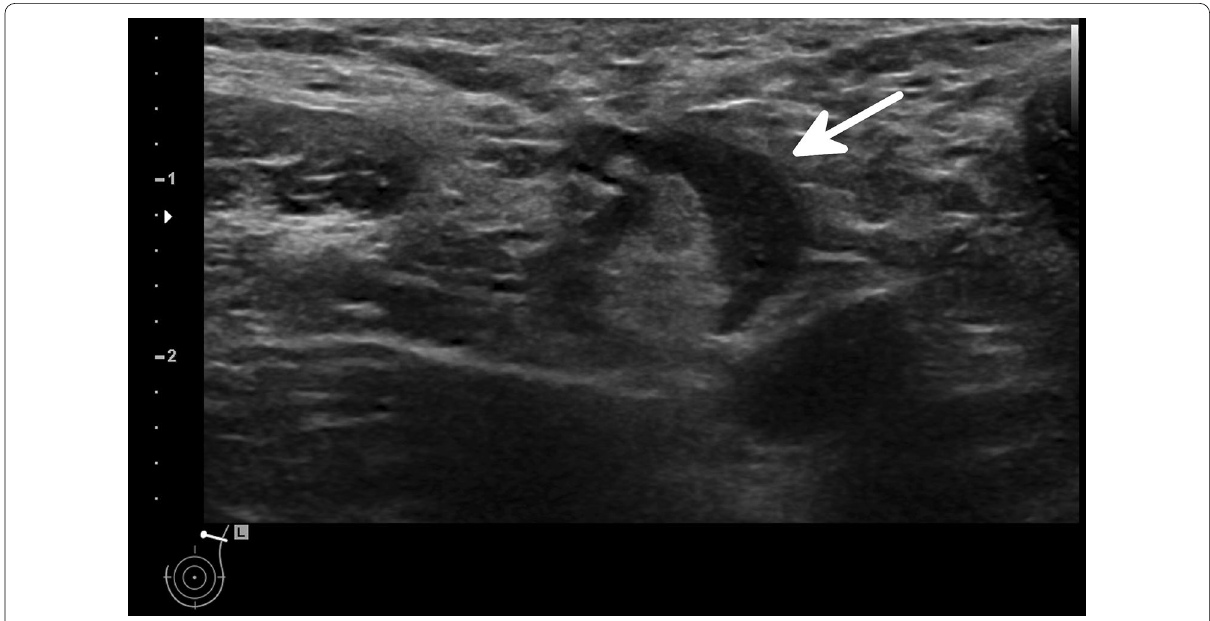
Fig. 1 Ultrasonography of the left axilla showing an enlarged 17 mm reactive lymph node in a 45‑year‑old woman about a week after receiving the first dose of the Vaxzevria COVID‑19 vaccine. Note the asymmetrical cortical thickening (white arrow) associated with a well‑represented central fatty